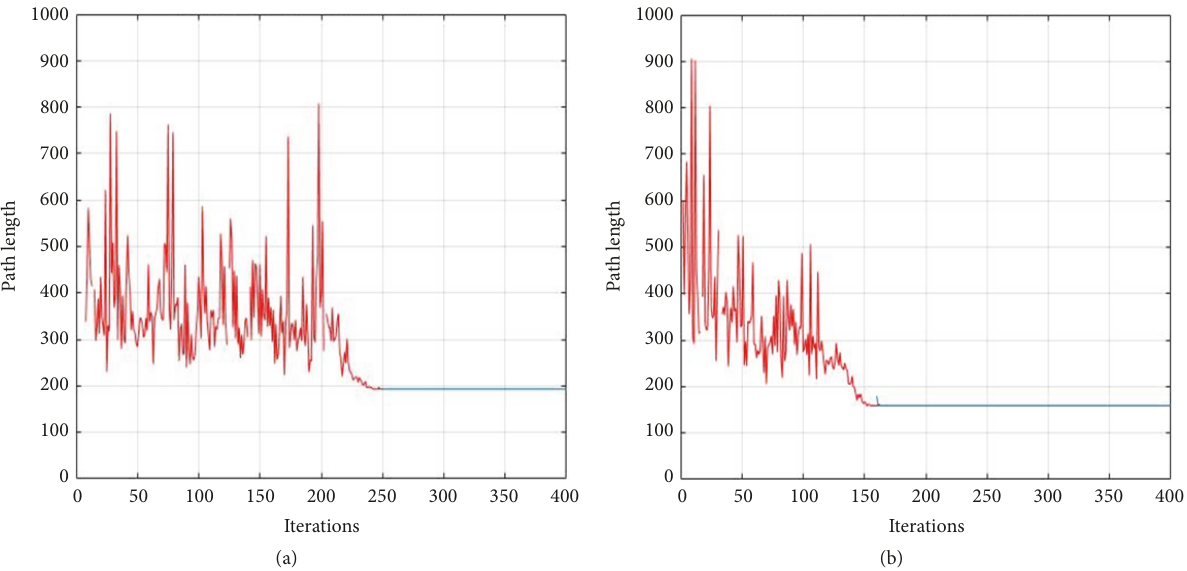
Figure 6: The optimal path length with the increase of iterations in one environment. There are both static and mobile threats in (a) and only mobile threats in (b).